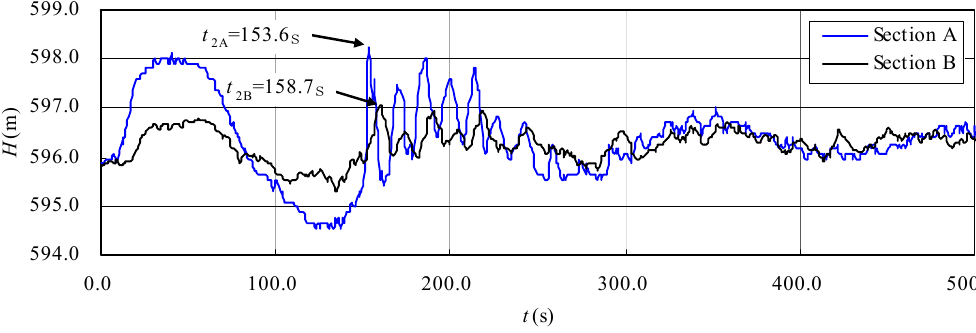
Figure 7. Time histories of the piezometric head at sections A and B under case C2.